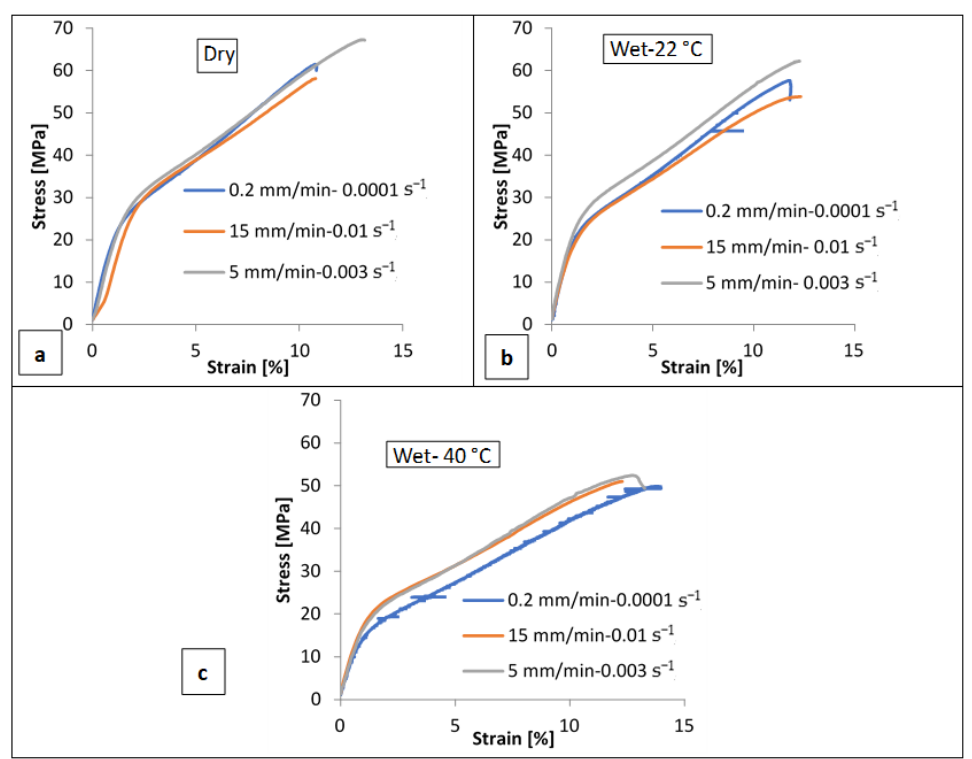
Figure 7. Engineering stress versus strain curves of BW30-0° specimens at 0.01 s − 1 , 0.003 s − 1 , and 0.0001 s − 1 strain rates under ( a ) dry, ( b ) wet-22 °C, and ( c ) wet-40 °C conditions.